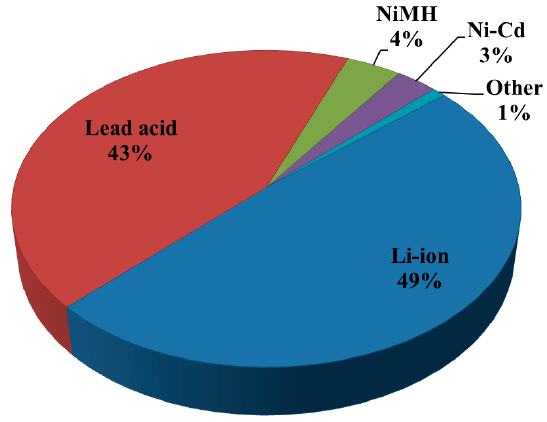
Figure 1. Market share of rechargeable battery chemistries in 2009 [3].